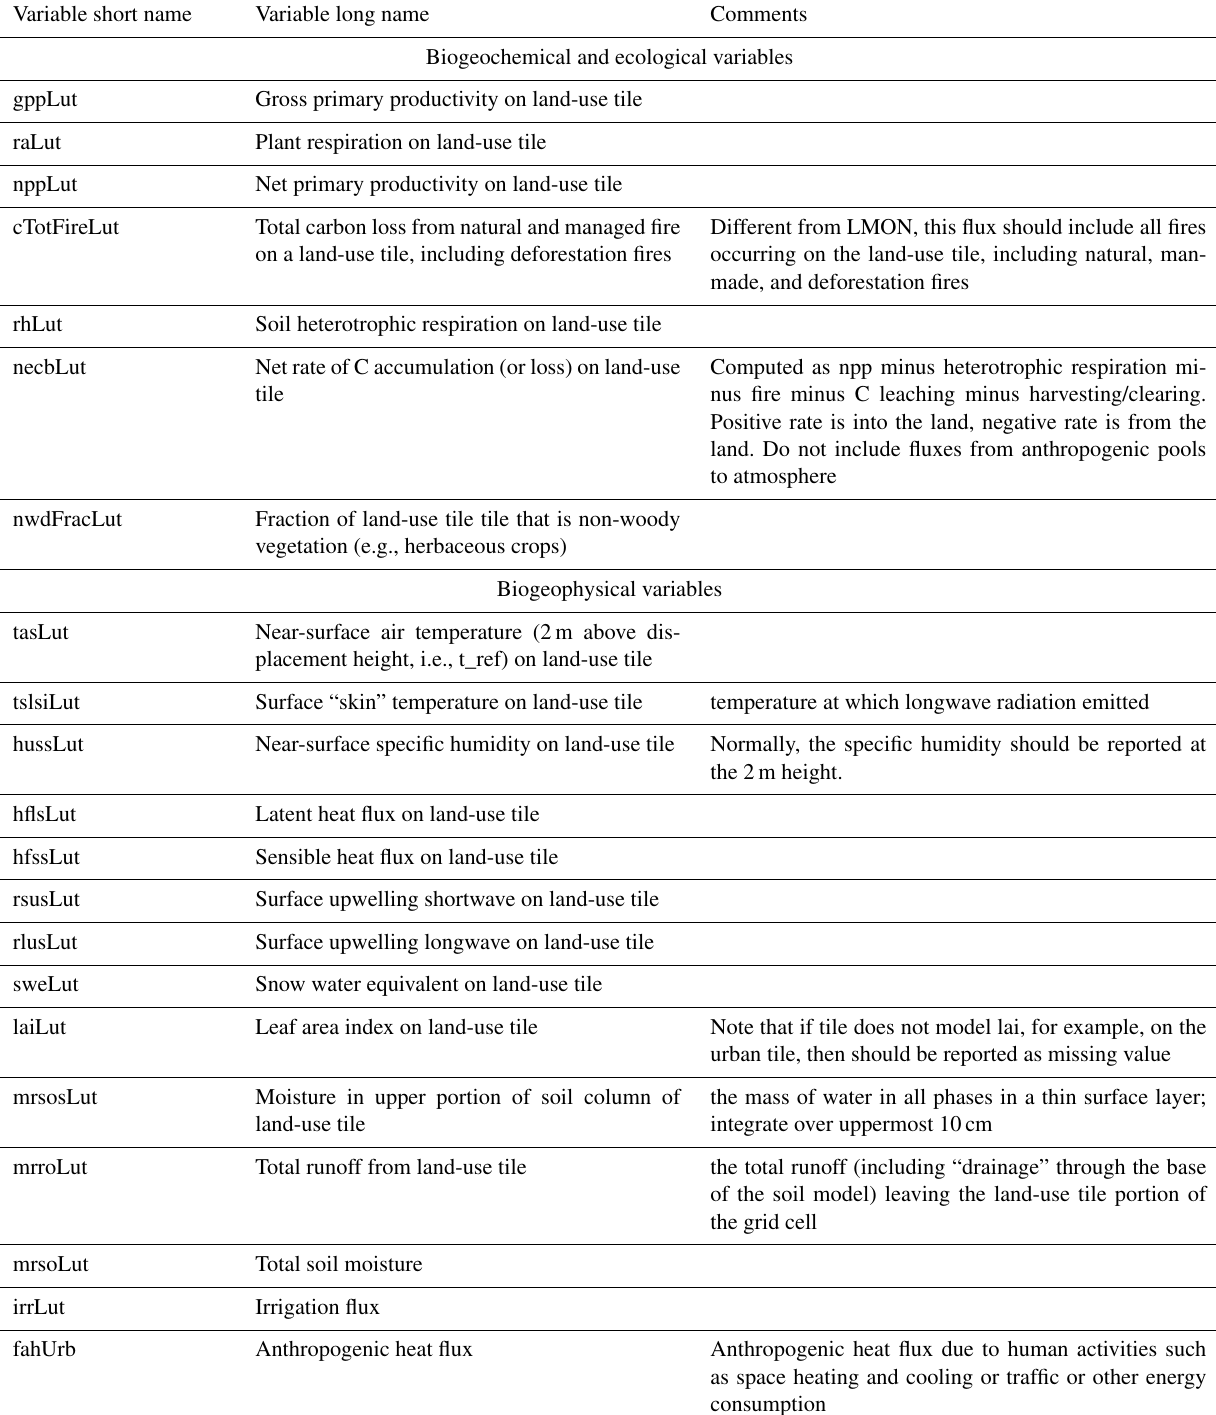
Table 5. List of requested variables on land-use tiles. Note that this list may be updated. Modelers should refer to the CMIP6 variable request lists for the final